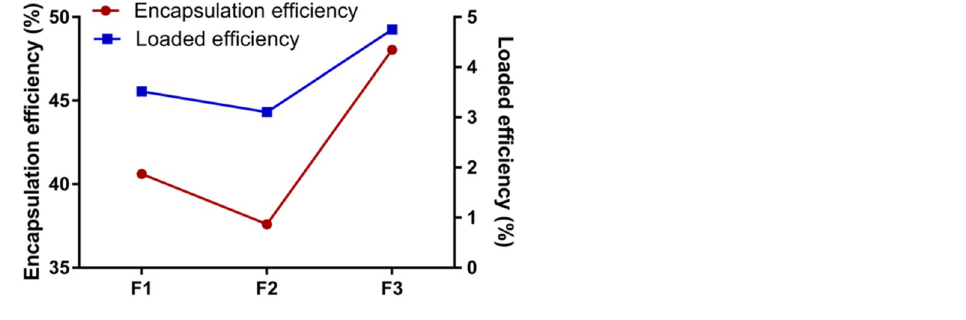
Figure 5. Encapsulation efficiencies are highly correlated to loading efficiencies of Dox with parameter of F1, F2 and F3, respectively. Microcarriers produced with F3 parameter shows the highest encapsulation efficiencies and loading efficiencies. Both efficiencies are highly correlated to each other in all groups.